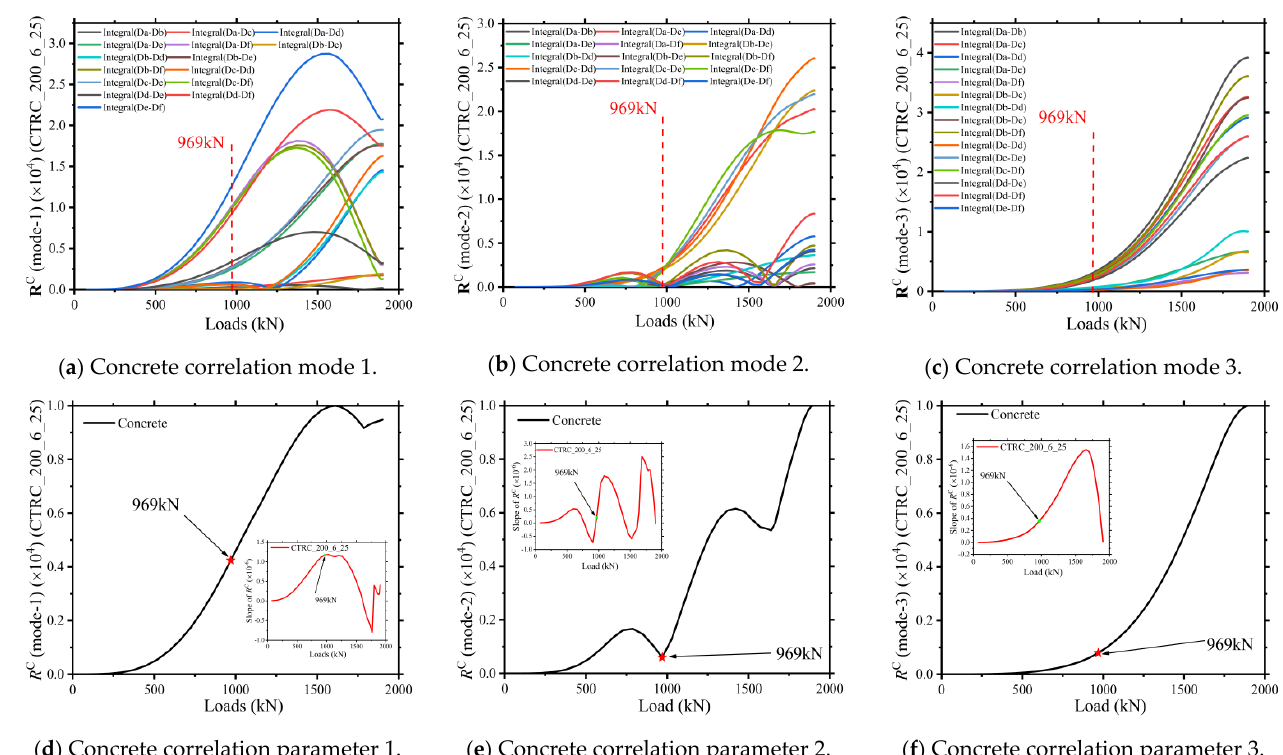
Figure 8. Concrete characteristic pairs of CTRC_200_6_25.